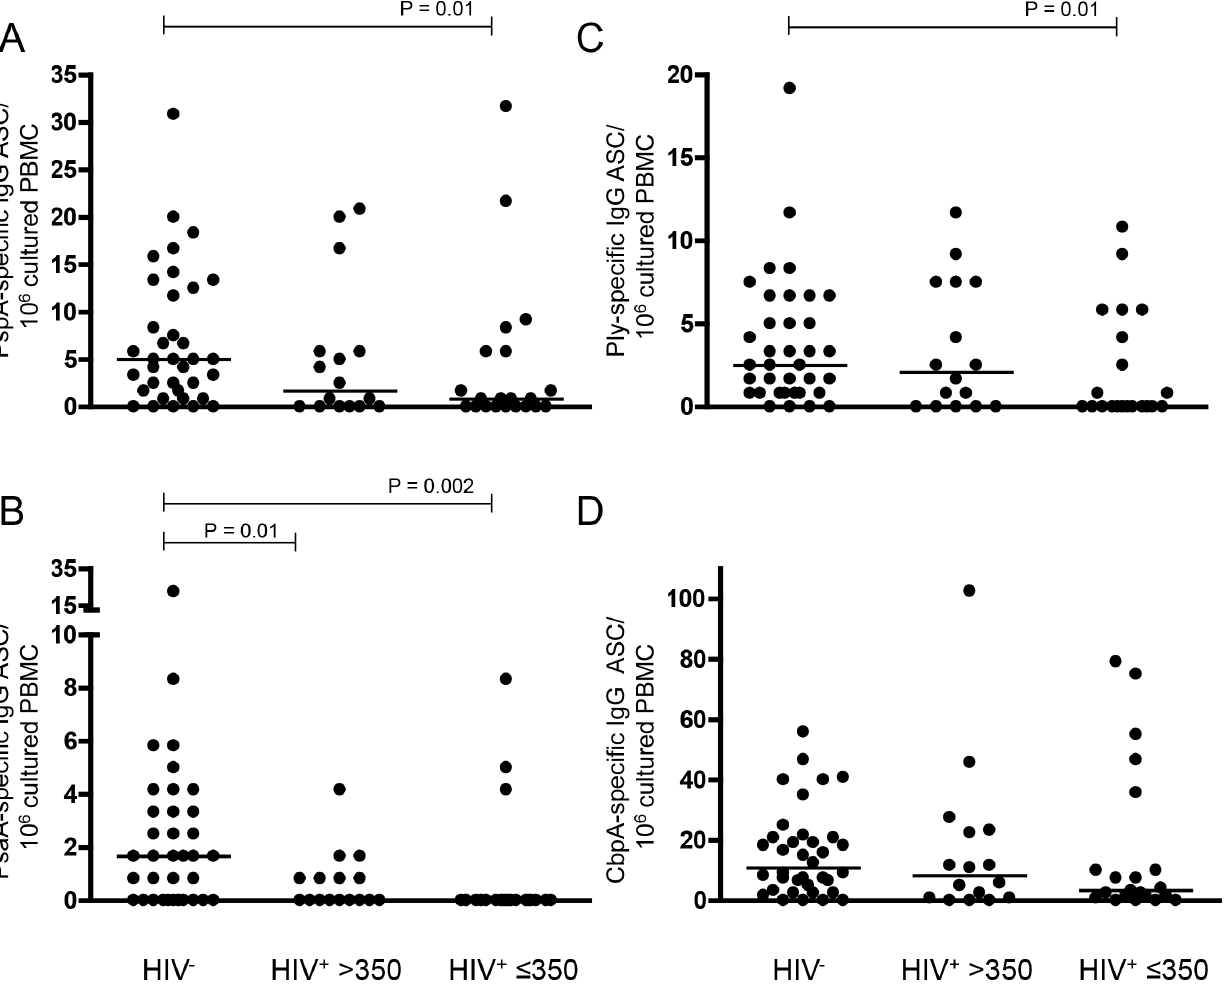
Figure 4. Loss of specific isotype-switched IgG memory B-cells in HIV-infected adults to pneumococcal protein antigens. Using an ELISPOT assay, following the expansion of memory B-cells with a cocktail of mitogens (SAC, PWM & CpG DNA) for six days, ( A ) Pneumococcal surface protein A (PspA), ( B ) Pneumococcal surface adhesion A (PsaA), ( C ) Pneumolysin (Ply), and ( D ) Choline binding protein A (CbpA) specific IgG antibody secreting cells (ASC) were enumerated in HIV 2 controls (n=36), HIV + . 350 (n=16) and HIV + # 350 (n=21) adults. Memory B-cell responses were expressed as numbers of ASC per million cultured PBMC seeded on the ELISPOT well. Each dot represents a mean of triplicates. Horizontal bars represent median values. Statistical significance of differences between groups was assessed using the Man Whitney U test.